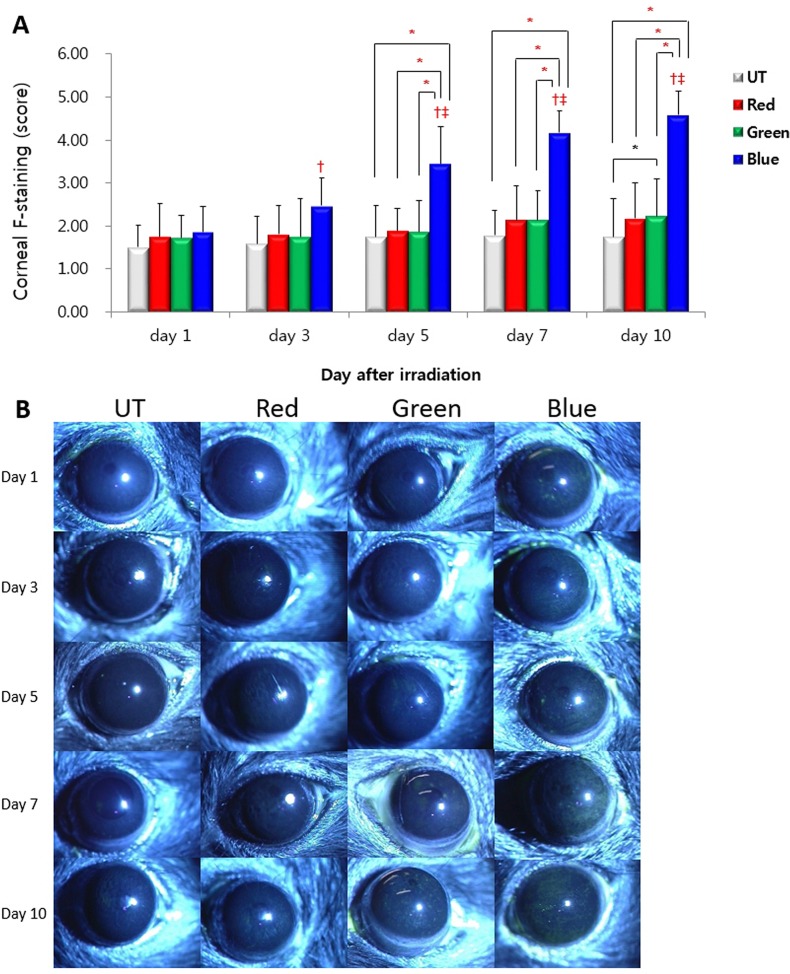
Corneal fluorescein staining scores (A) and representative figures (B) in the untouched (UT), red, green and blue groups at day 1, 3, 5, 7, and 10. * P < 0.05 compared between groups. †
P < 0.05 compared with the day 1 value. ‡
P < 0.05 compared with the day 3 value.